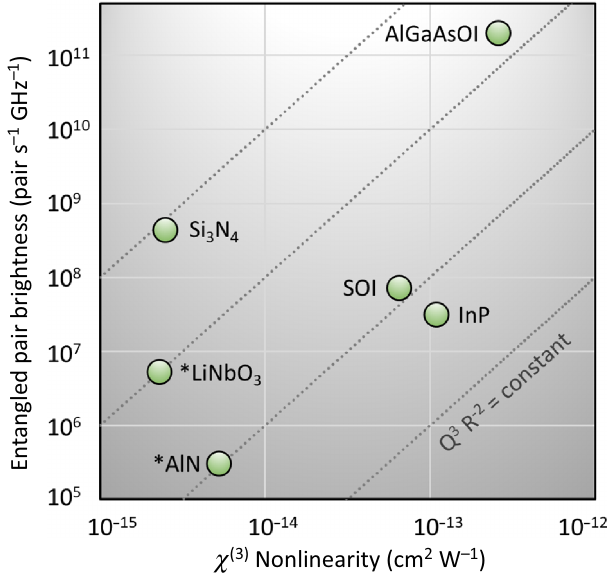
FIG. 1. The on-chip entangled-photon-pair brightness plotted as a function of the χ ( 3 ) nonlinear coefficient of the material. All brightness values are normalized to 1 mW on-chip power for comparison. LiNbO 3 and AlN generate entangled-photon pairs via χ ( 2 ) processes (as indicated by an asterisk) but they are plot- ted here using their χ ( 3 ) coefficients for simplicity. Isolines of constant Q 3 R − 2 are illustrated by the dashed lines. The data for the materials are estimated from the references shown in Table